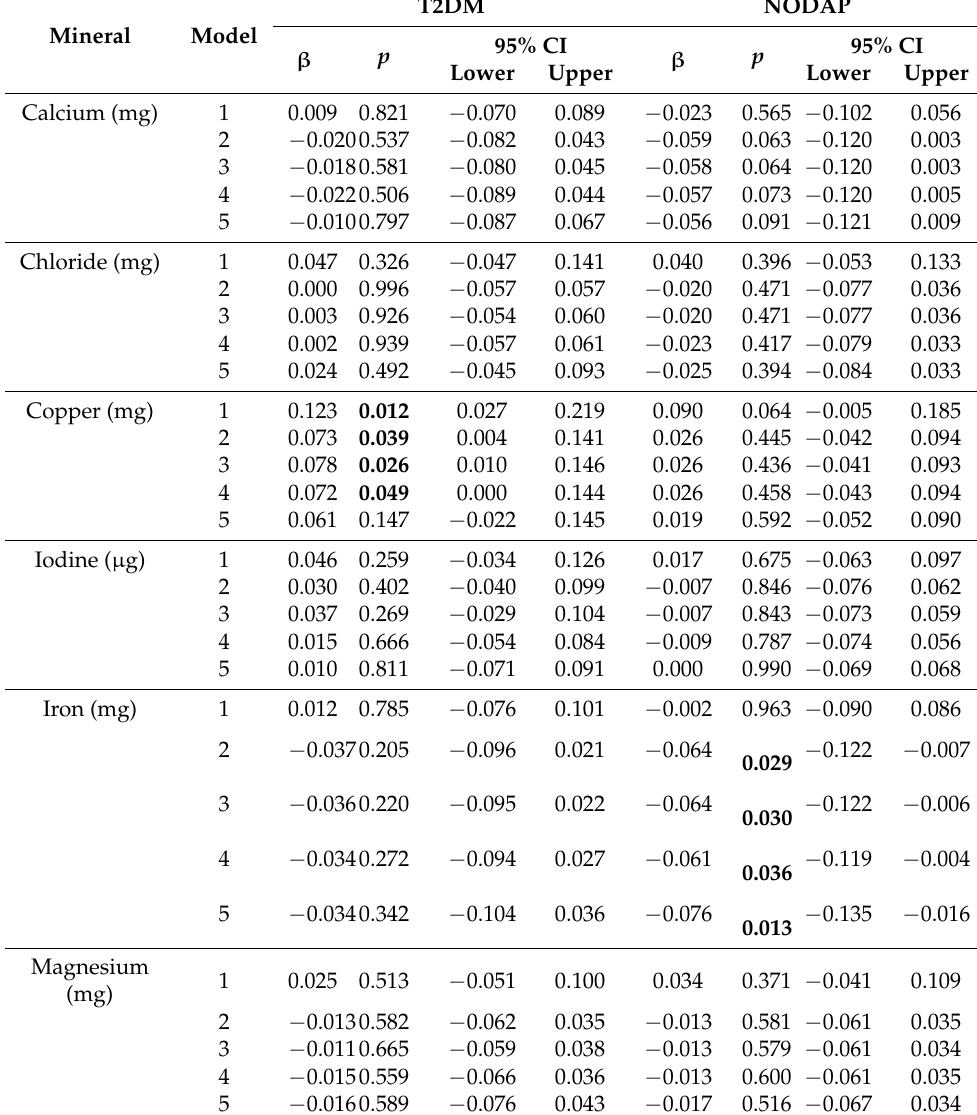
Table 2. Associations between habitual mineral intake and the study